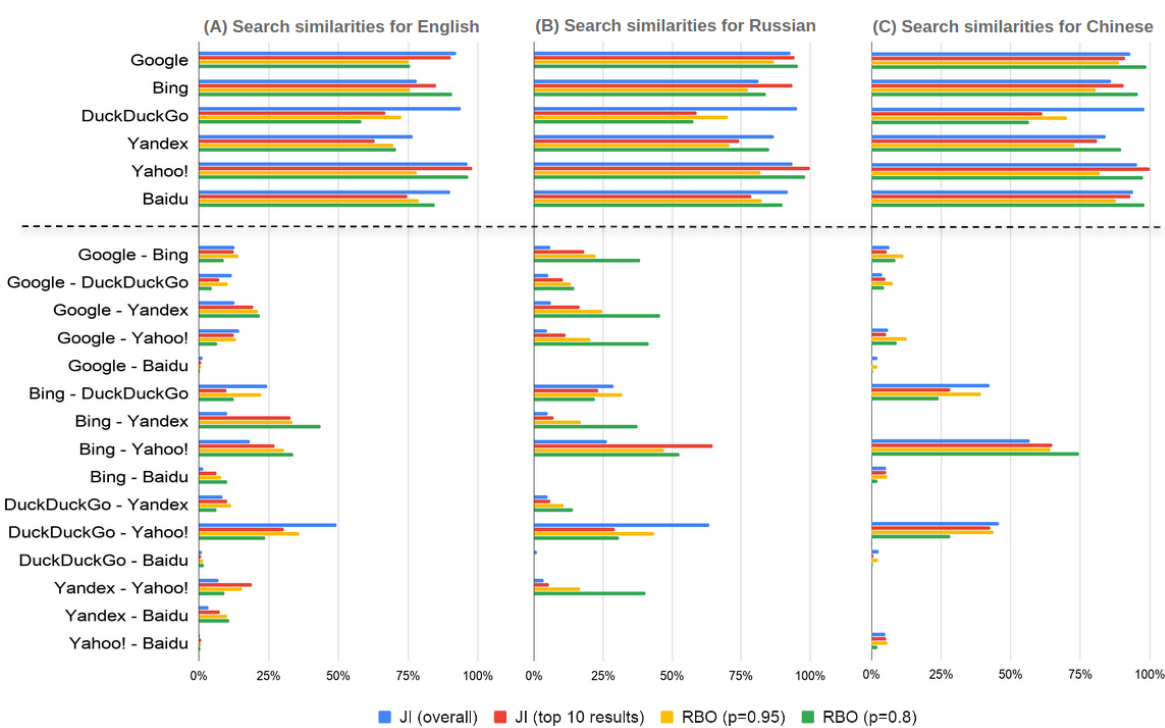
Figure 1A. Similarity metrics for the “US elections” query results. JI stands for the Jaccard index and RBO stands for the Ranked Biased Overlap. The x-axis shows the average percentage for each of the similarity metrics, and the y-axis shows the pairs of search engines that are compared.